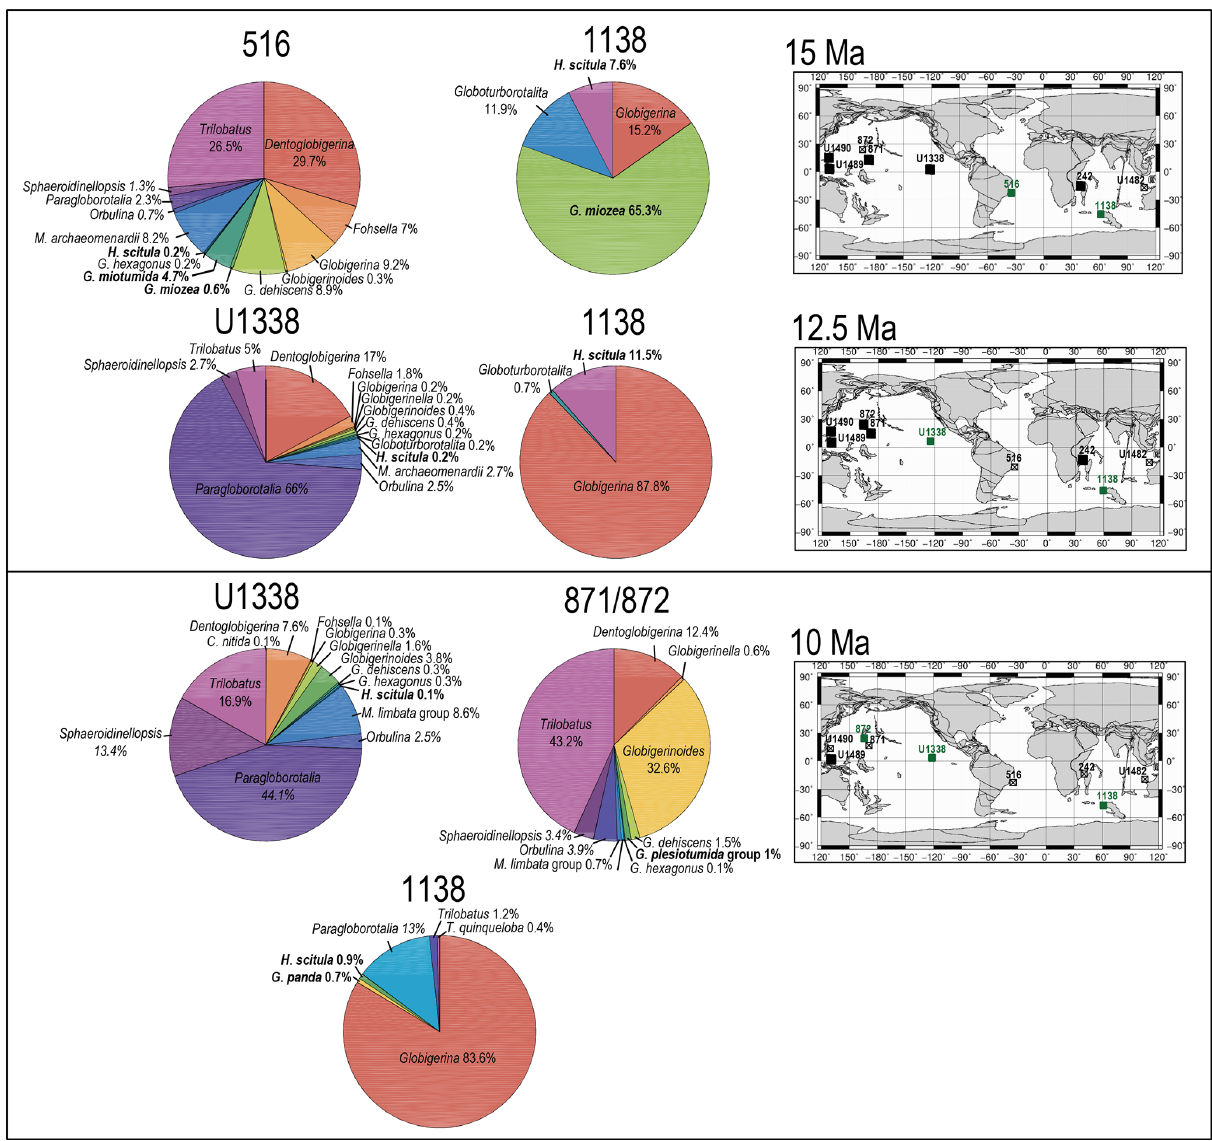
Figure 7. Abundance and biogeography of planktonic foraminiferal species at 15, 12.5, and 10Ma. In the pie charts, the twilight zone planktonic foraminiferal species are in bold. Sites where twilight zone planktonic foraminifera were found are highlighted in green in the maps. The crossed square symbols in the maps indicate that the time interval of interest was not recovered for a given site. Continental configuration follows the Ocean Drilling Stratigraphic Network (GEOMAR; Kiel,